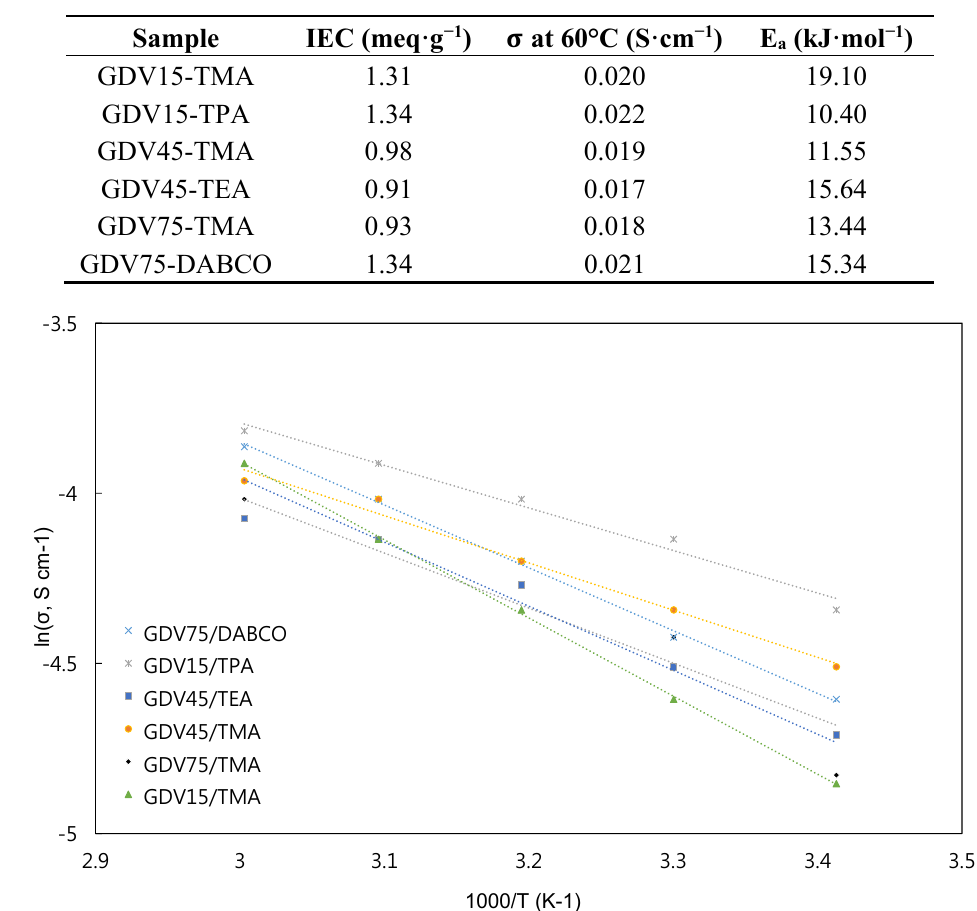
Table 4. Ion exchange capacity (IEC), conductivity and activation energy of select quaternized membranes.